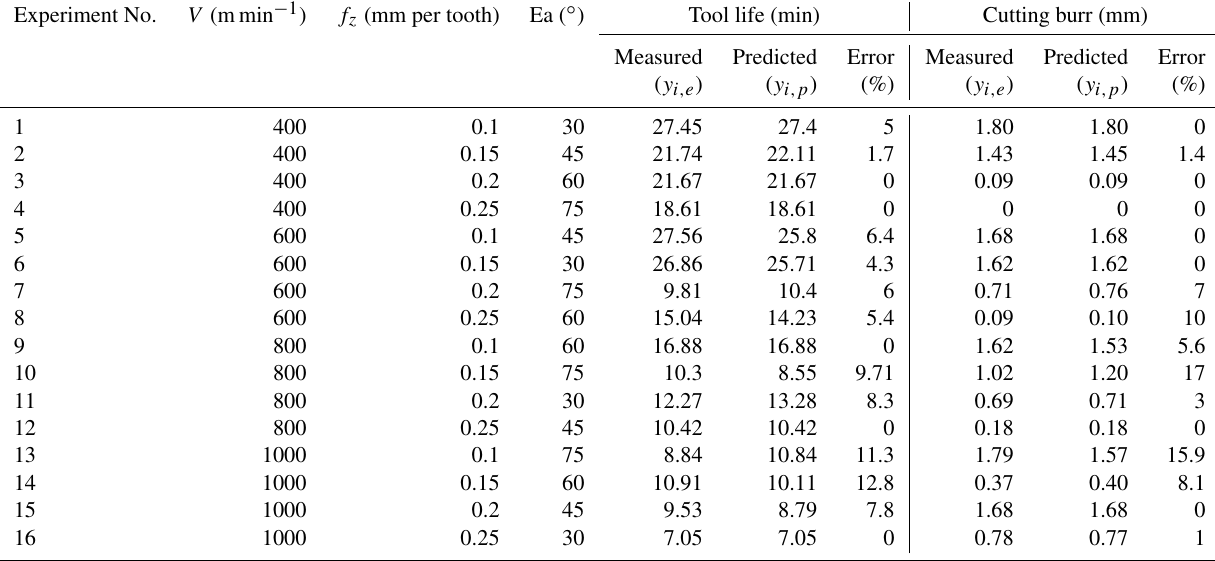
Table 5. The measured and predicted values of tool life and heights of cutting burr for training data set. Experiment No.